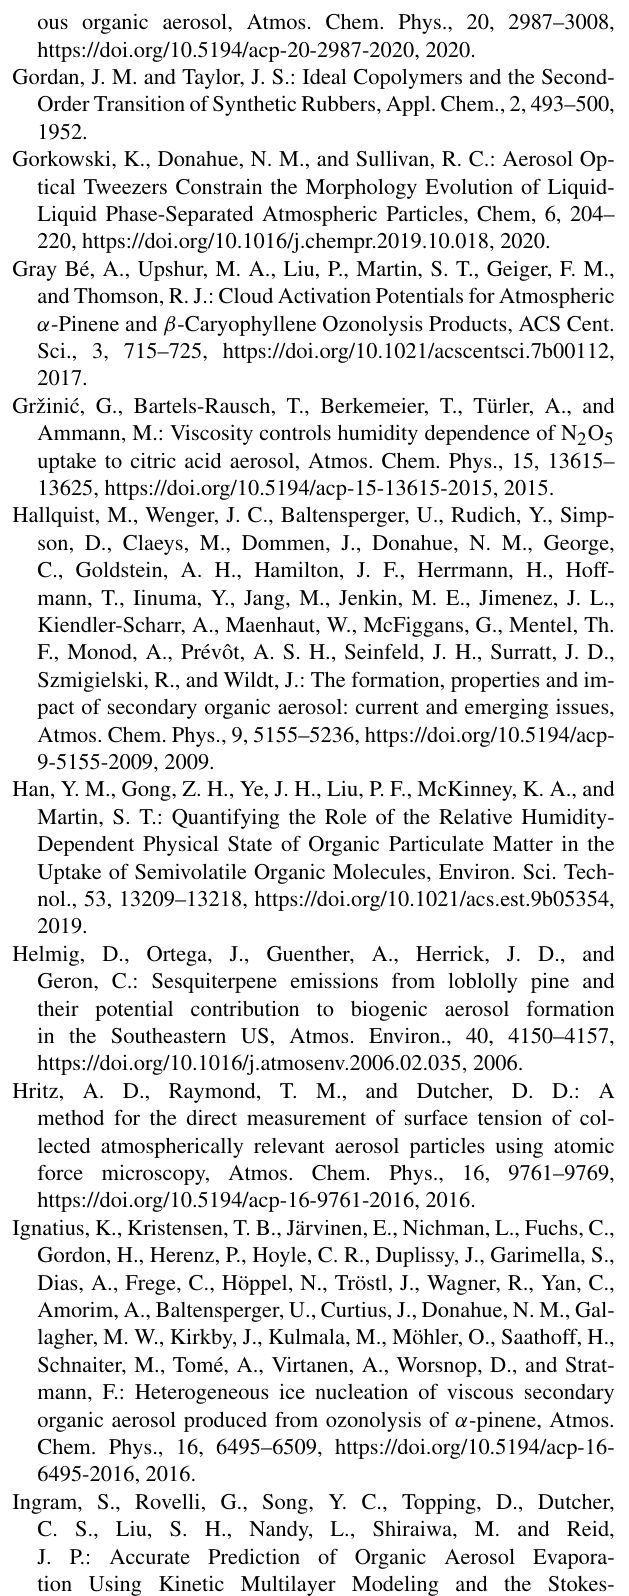
Joseph, and Tabeling, P.: Direct measurement of the apparent slip length, Phys. Rev. E, 71,